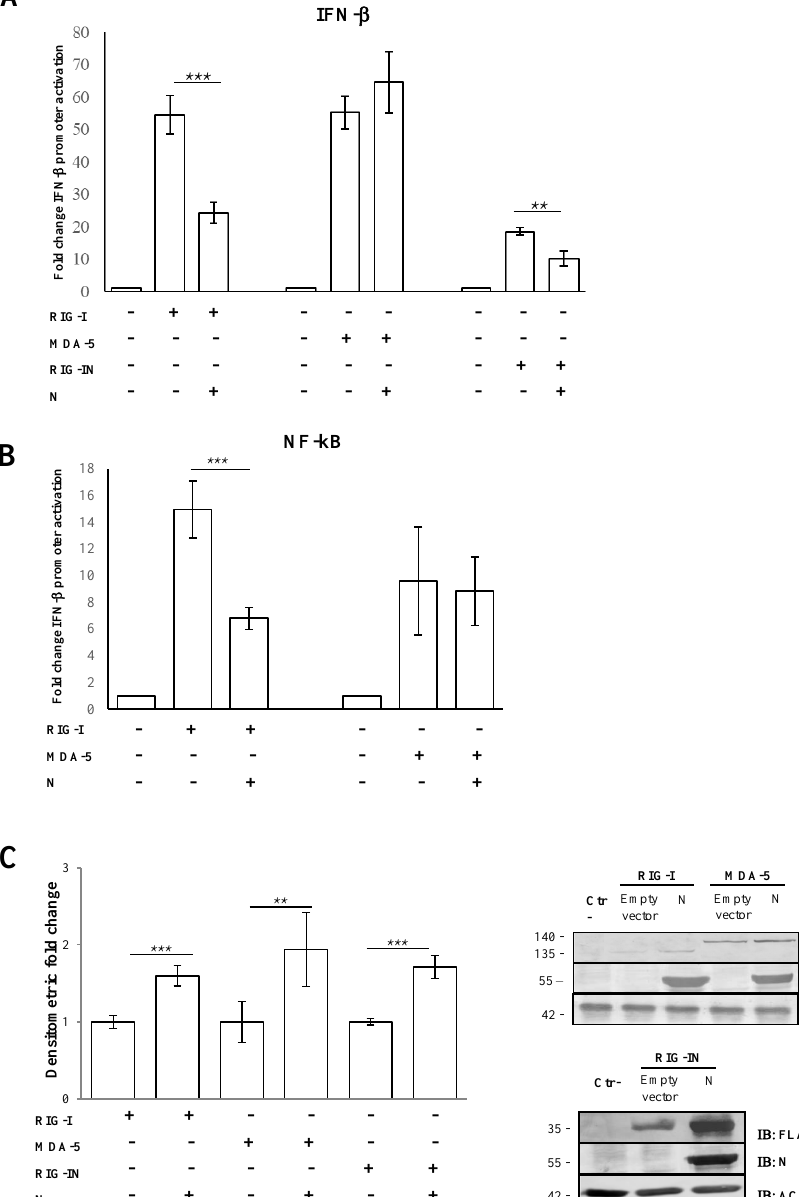
Figure 1. SARS-CoV-2 N counteracts RIG-I-mediated signaling. ( A ) SARS-CoV-2 N protein inhibited IFN- β promoter activation. Lenti-X 293T cells were co-transfected with the IFN- β Firefly luciferase reporter plasmid, RIG-I-, RIG-IN- or MDA-5-expressing plasmids, with or without the N-expressing plasmid. Renilla luciferase control reporter plasmid was included as an internal control for further normalization. Firefly luciferase activities were normalized with respect to Renilla luciferase values, and fold induction was estimated with respect to the relative mock-treated sample. ( B ) The inhibitory effect of SARS-CoV-2 N protein on the minimal IFN- β promoter containing the NF- κ B responsive element was assessed by a luciferase reporter assay, as described above. ( C ) Fifty micrograms of whole cell lysates (WCLs) were further analyzed by immunoblotting for RIG-I, RIG-IN, MDA-5 and N proteins using anti-FLAG M2 and anti-N monoclonal antibodies. Loading control was represented by the immuno-detection of actin protein. Densitometric analyses of reactive bands were performed with ImageJ software. Results are plotted as the mean fold change in RIG-I, RIG-IN or MDA-5 with respect to relative actin levels from ( n = 3) independent experiments ± SD. Significance was determined with p -values (*** p < 0.005, 0.005 < ** p <